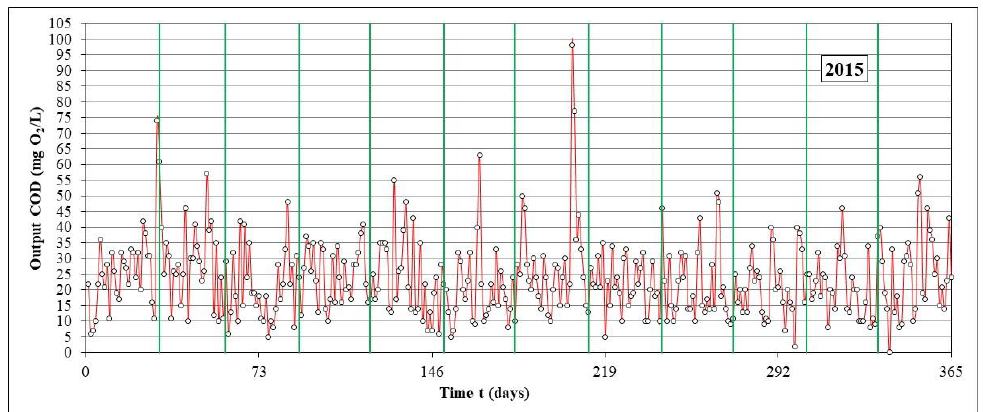
Figure 5. Output of COD for year 2015.